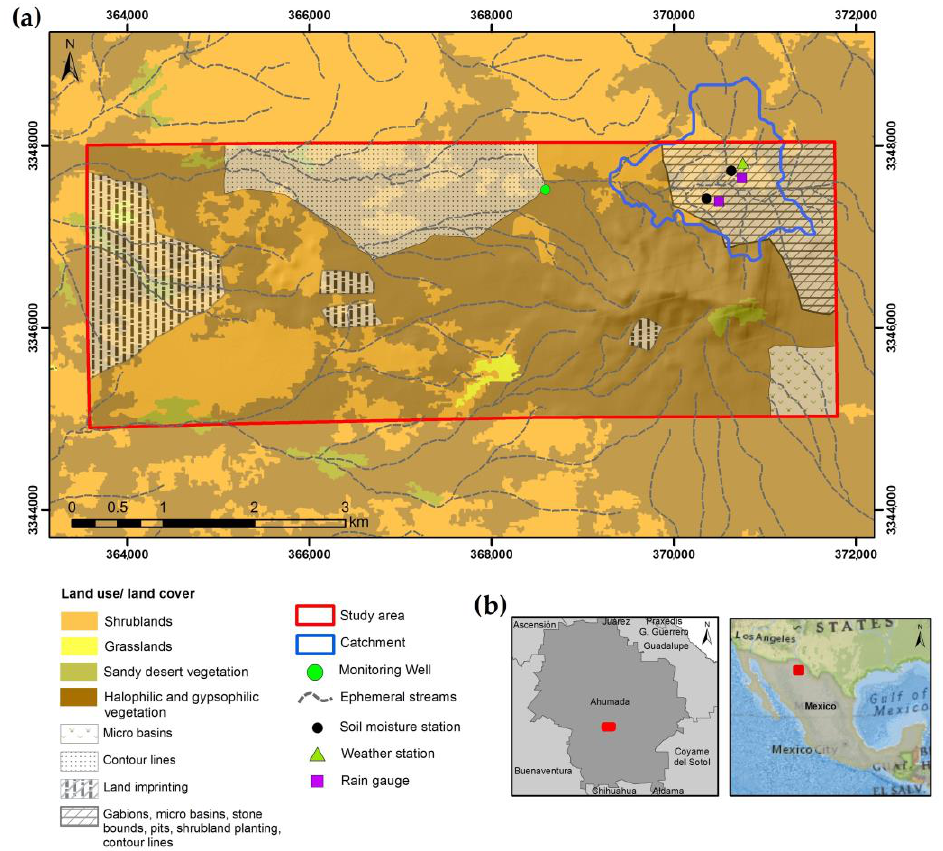
Figure 1. Location and instrumentation of the study site. ( a ) Study area showing ephemeral streams, catchment, and land cover, ( b ) Location of the study area within the municipality of Ahumada (left) and the country of Mexico (right). This map was created using ArcGIS 10.5 ® software. ArcGIS ® is the intellectual property of ESRI and is used herein under license. Copyright © ESRI. All rights reserved. For more information about ESRI ® software, please visit www.esri.com (accessed on 10 September 2022). Basemap credits: ESRI, DigitalGlobe, GeoEye, i-cubed, USDA FSA, USGS, AEX, Getmapping, Aerogrid, IGN, IGP, swisstopo, and the GIS User